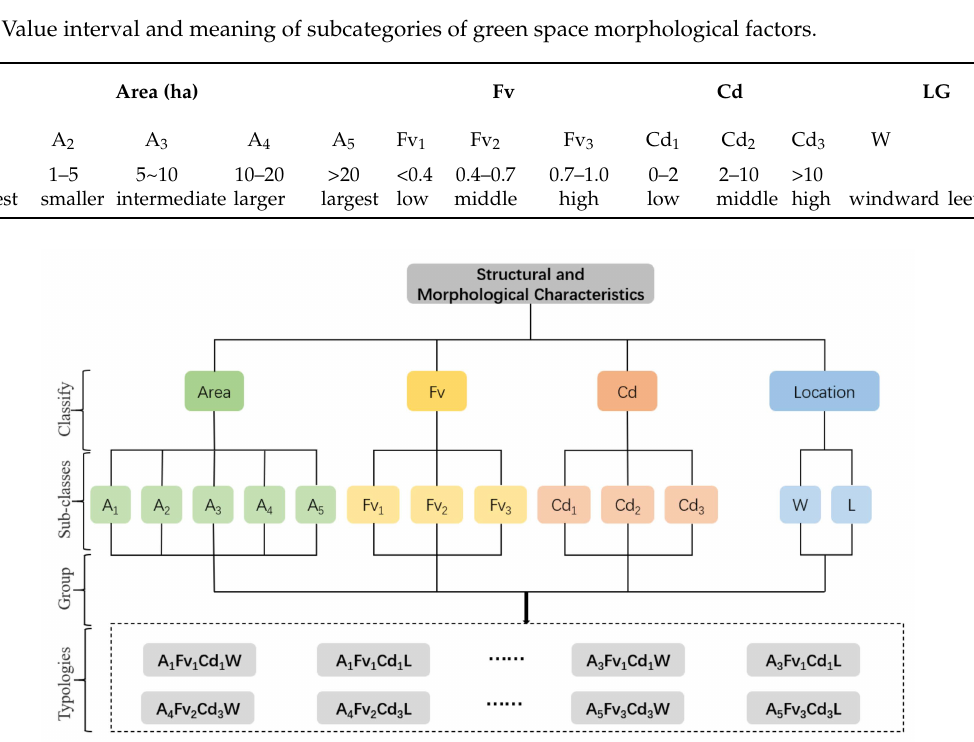
Figure 5. Logical division and classification of green space morphological